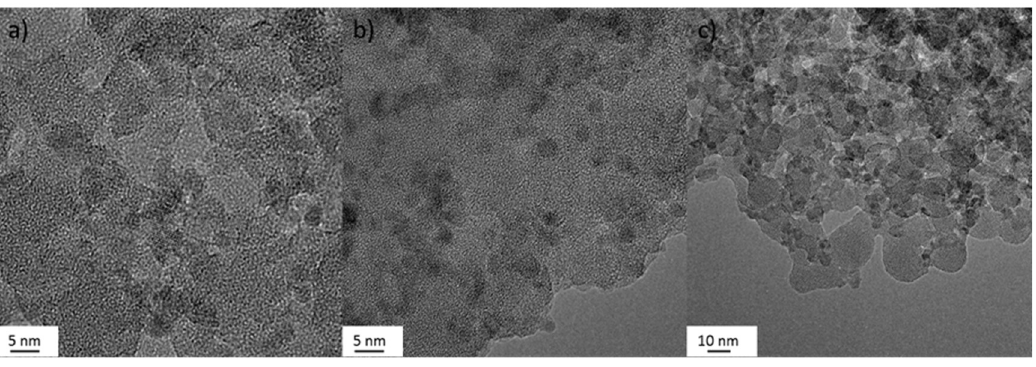
Figure 1. TEM images of TiO 2 :SiO 2 sample: ( a ) TiO 2 :SiO 2 1:1, ( b ) TiO 2 :SiO 2 1:3, ( c ) TiO 2 :SiO 2 3:1.